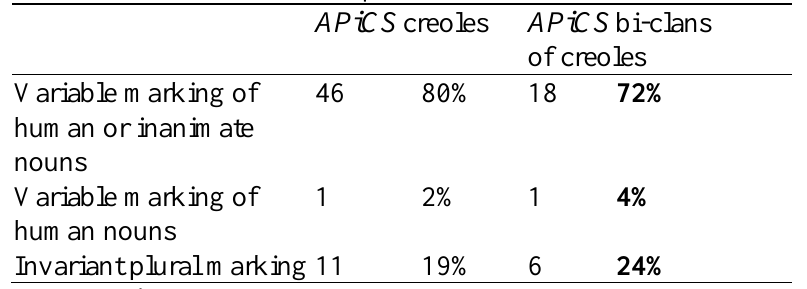
Table 9. Occurrence of nominal plural